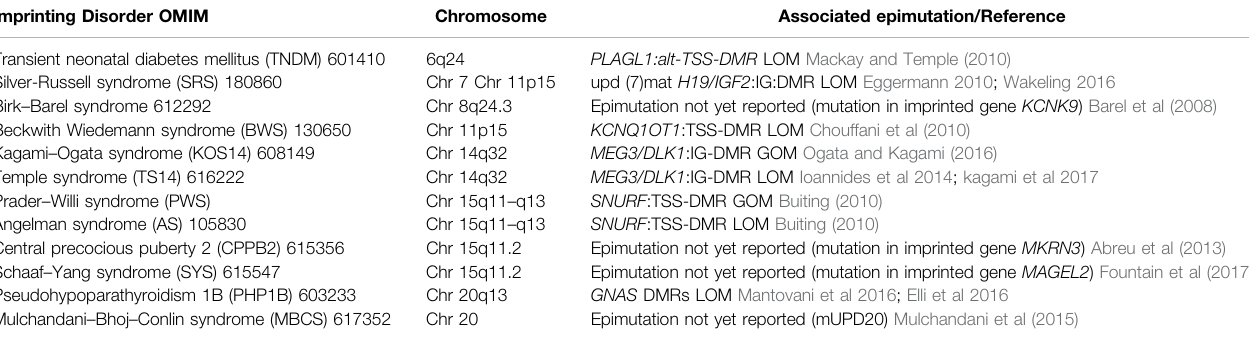
TABLE 1 | Overview on the twelve known imprinting disorders. Adapted from Mackay DJG, Temple IK (2017). Imprinting Disorder